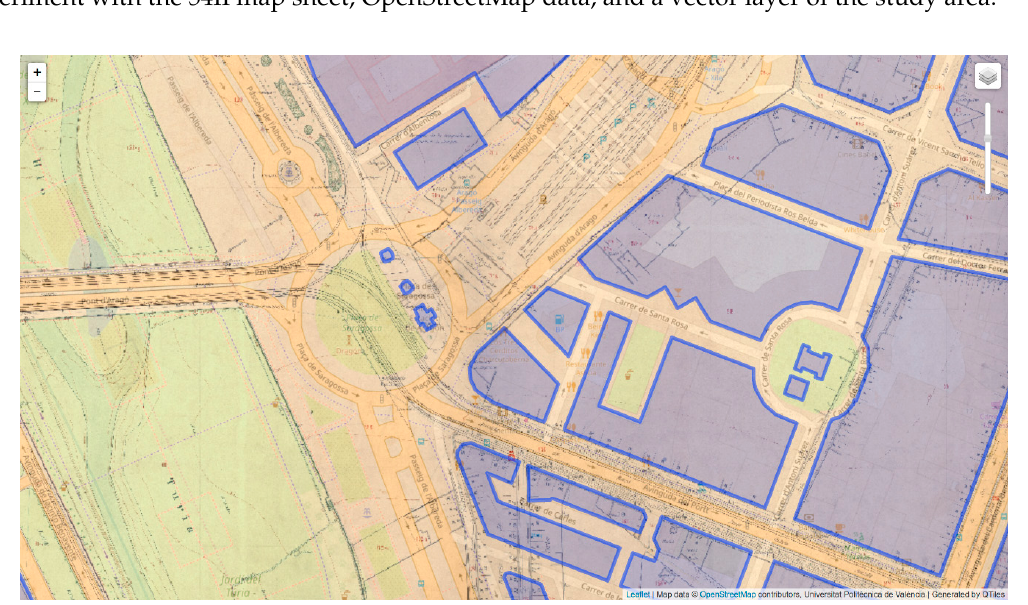
Figure 6. A detail of the former Aragón Railway Station at zoom levels 17 (left) to 20 (right). Note the increasing detail of the map elements in upper levels.